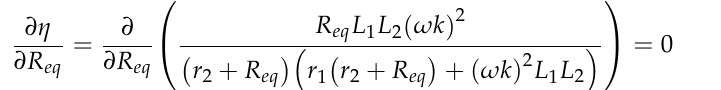
Figure 9. Evolution of the voltage gain as a function of the frequency for different values of the coupling coefficient and for a fixed load.